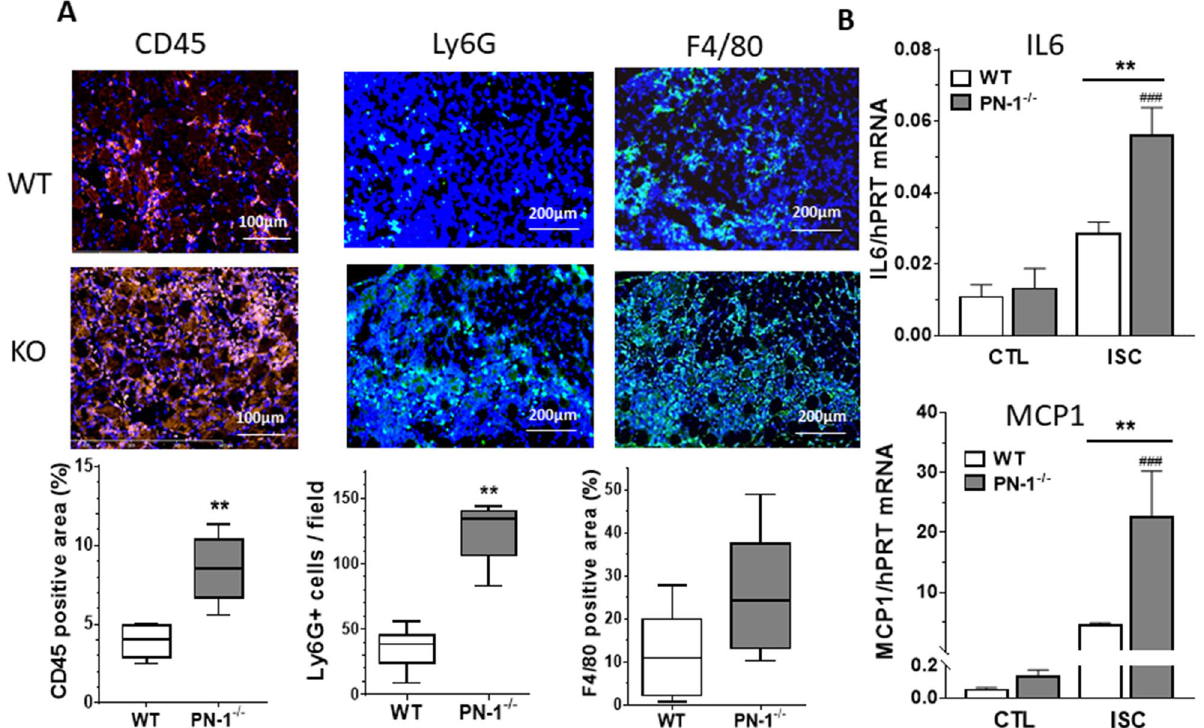
Figure 6. PN-1 deficiency results in higher leucocyte infiltration. Leukocytes, neutrophils and macrophages were visualized by immunostaining of ischemic muscles from WT and PN-1 −/− mice, 3 days after surgery, with antibodies to CD45, Ly6G and F4/80, respectively (green), and nuclei were stained with DAPI. Representative images are shown (n = 6 mice of each group). Ly6G positive cells per field were manually counted and CD45 and F4/80 positive areas were quantified as the percentage of total area using Image J software. MannWhitney ** p < 0.01; for F4/80: p = 0,1775. * KO versus WT and # ischemic versus